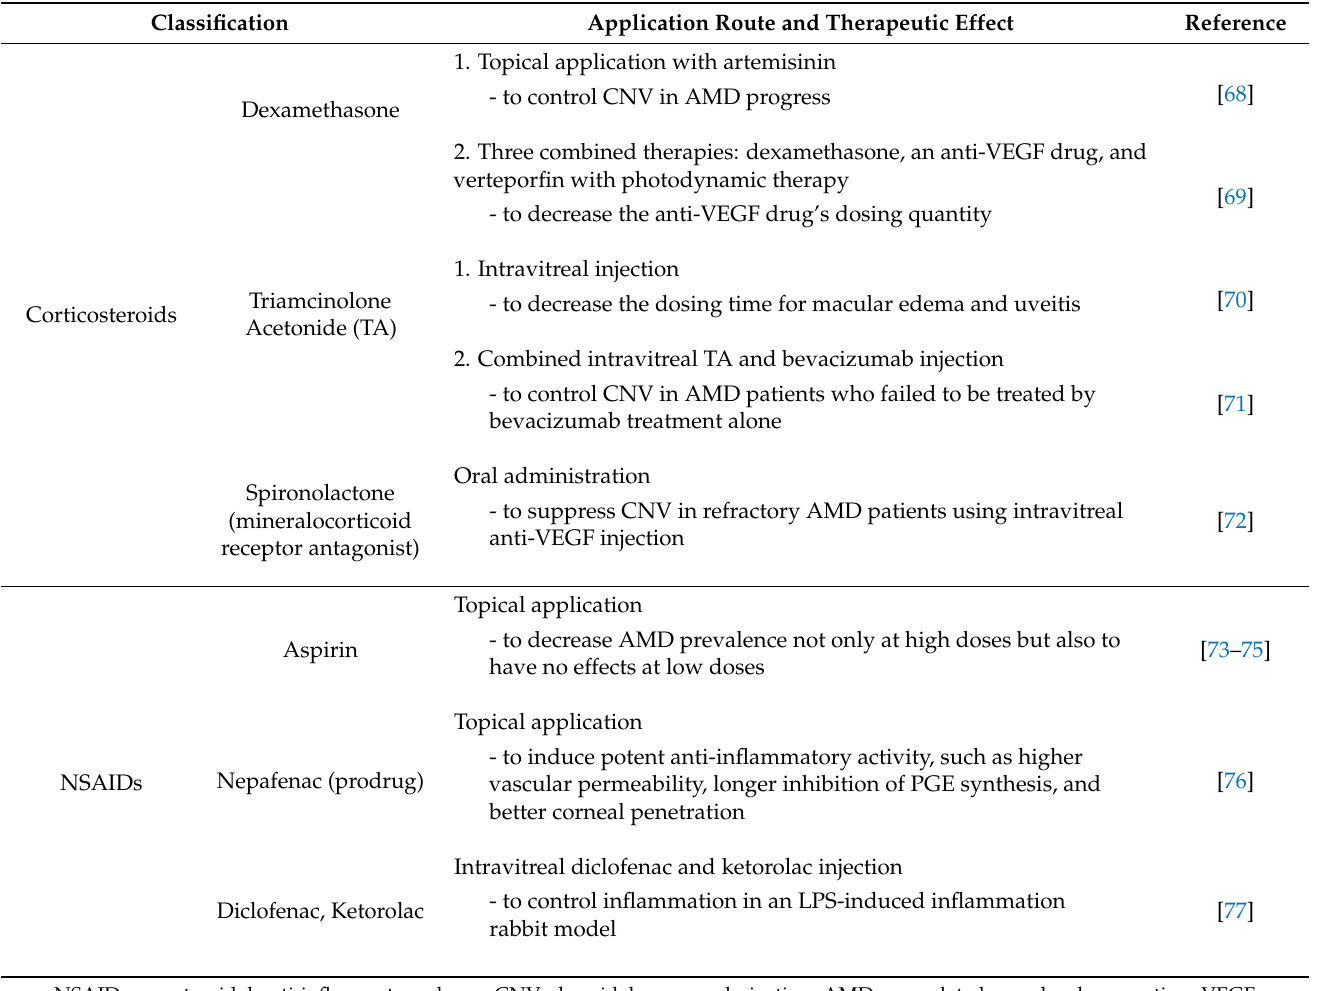
Table 4. Summary of anti-inflammatory drugs for AMD